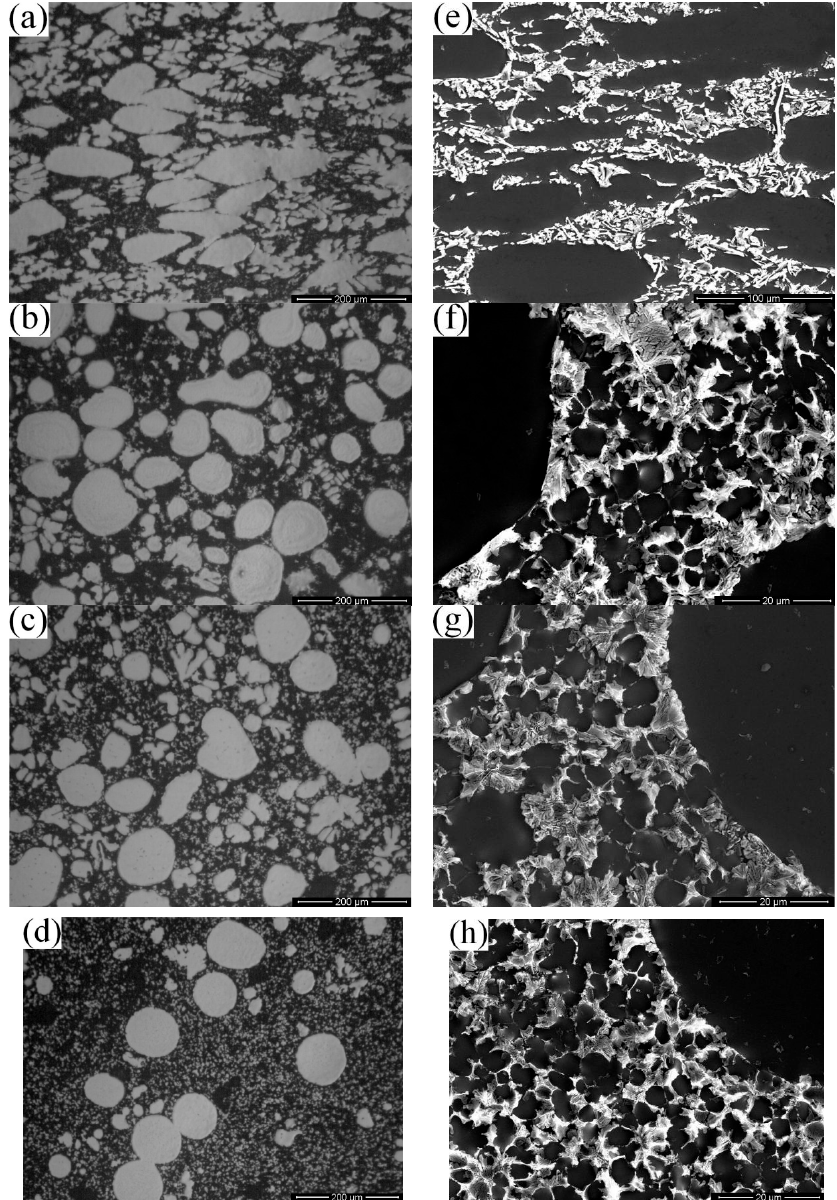
Figure 7. Microstructures in different positions of die casting: ( a , e ) biscuit, A; ( b , f ) in-gate, B; ( c , g ) down, C; ( d , h ) middle, D.